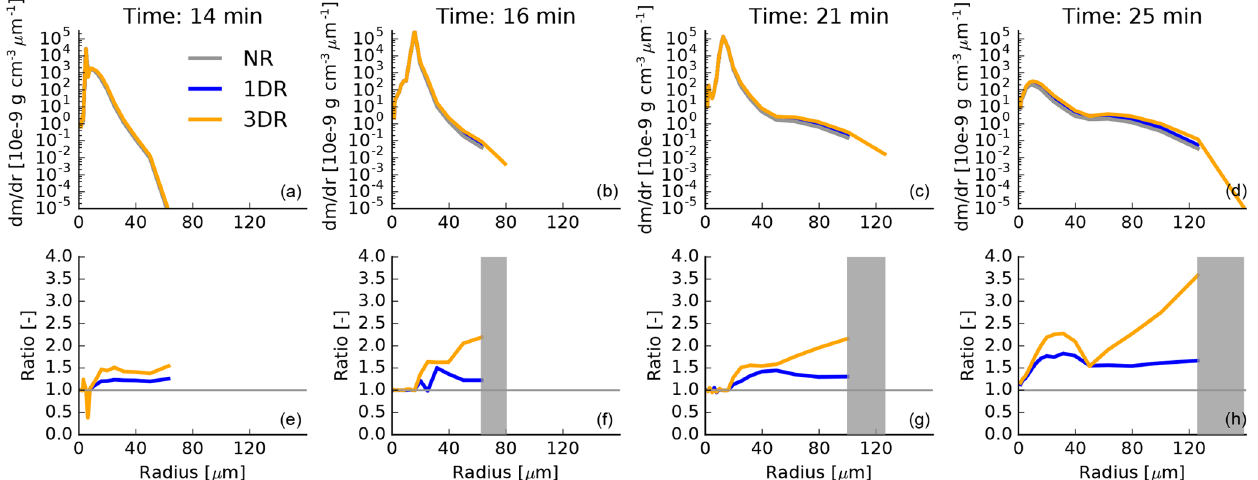
Figure 6. Drop size distribution d m/ d r plot for the four selected time steps displayed by the red dotted line in Fig. 5. (a) – (d) show d m/ d r . The lower row shows the ratio between the NR case and the 1DR and 3DR case. Gray areas in (e) – (h) display size bins where mass occurs in the 1DR and 3DR case but not the 1DR case and therefore no ratio could be calculated.